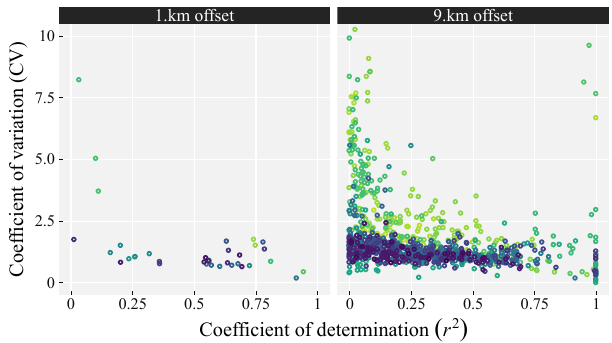
Figure 7. Scatter plot of the performance of individual CMLs against gauges (coefficient of variation against coefficient of de- termination). The left panel (“1.km offset”) is for gauges within 1km from the selected CMLs. The right panel (“9.km offset”) is for gauges within 9km from the selected CMLs. Each distinguish- able colour in the plots represents the metrics of an individual CML, i.e. one colour per evaluated CML (regardless of its gauge compari- son). The metrics are for cases in which both CML and gauge rain- fall depths are above 0 . 0mm (Fig. 6, right column). RAINLINK estimates are computed for the SP R − k